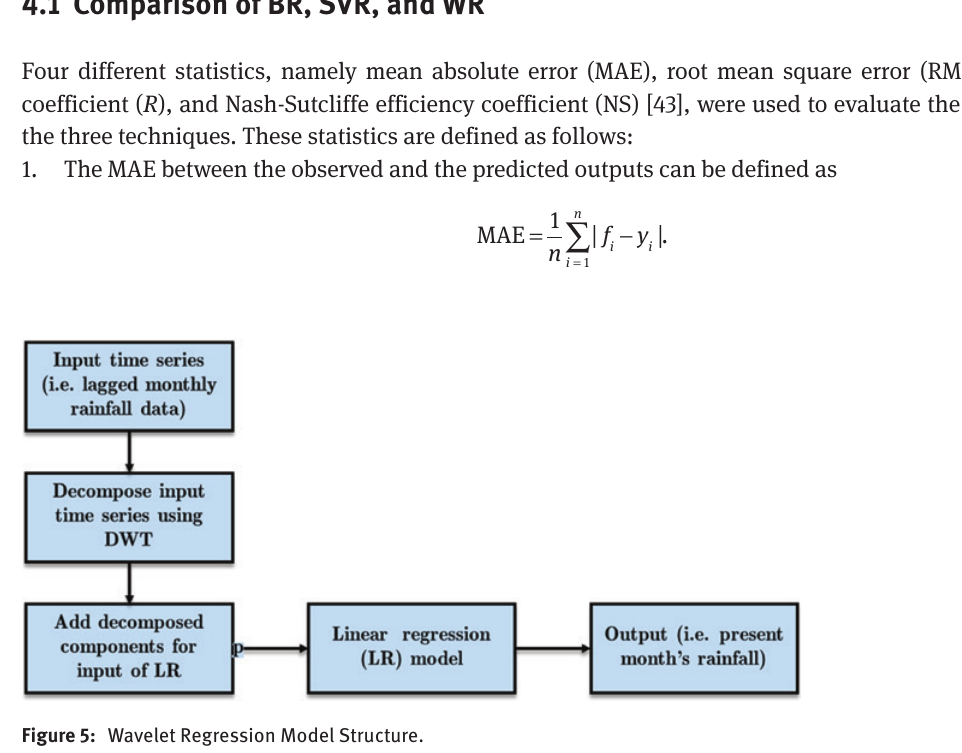
Figure 5: Wavelet Regression Model Structure.